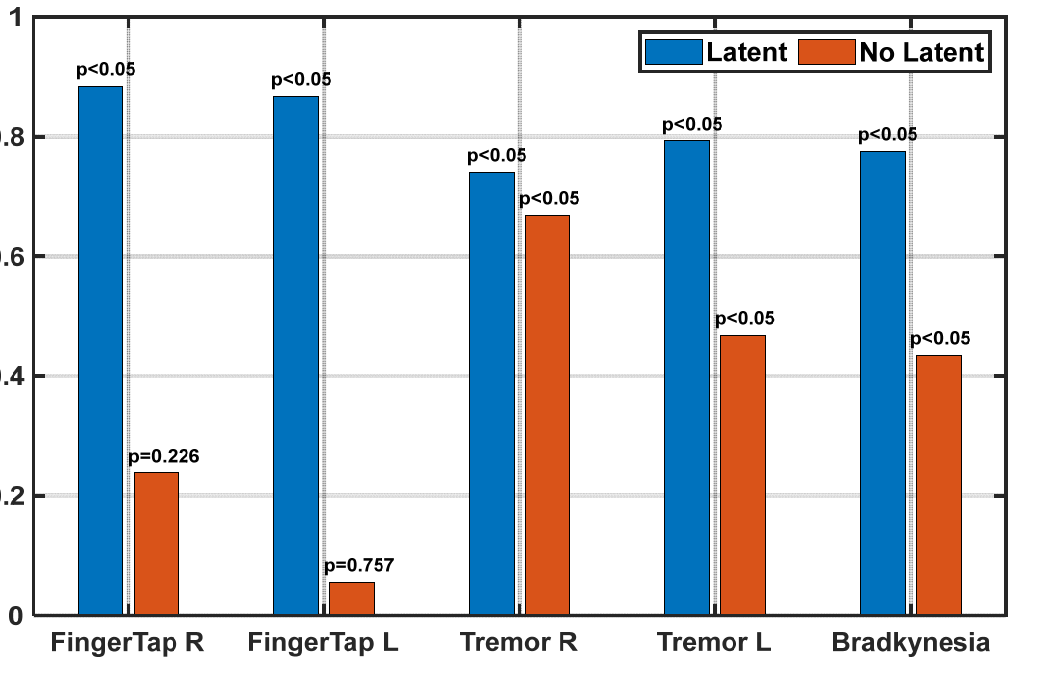
Figure 5. Correlations and the related p -values for the fitted LASSO models on two latent space and non-latent space cases to regress the clinical scores. Table 6. t-Statistics values between the correlation of latent and non-latent space values with each clinical data sample for the 30 runs.